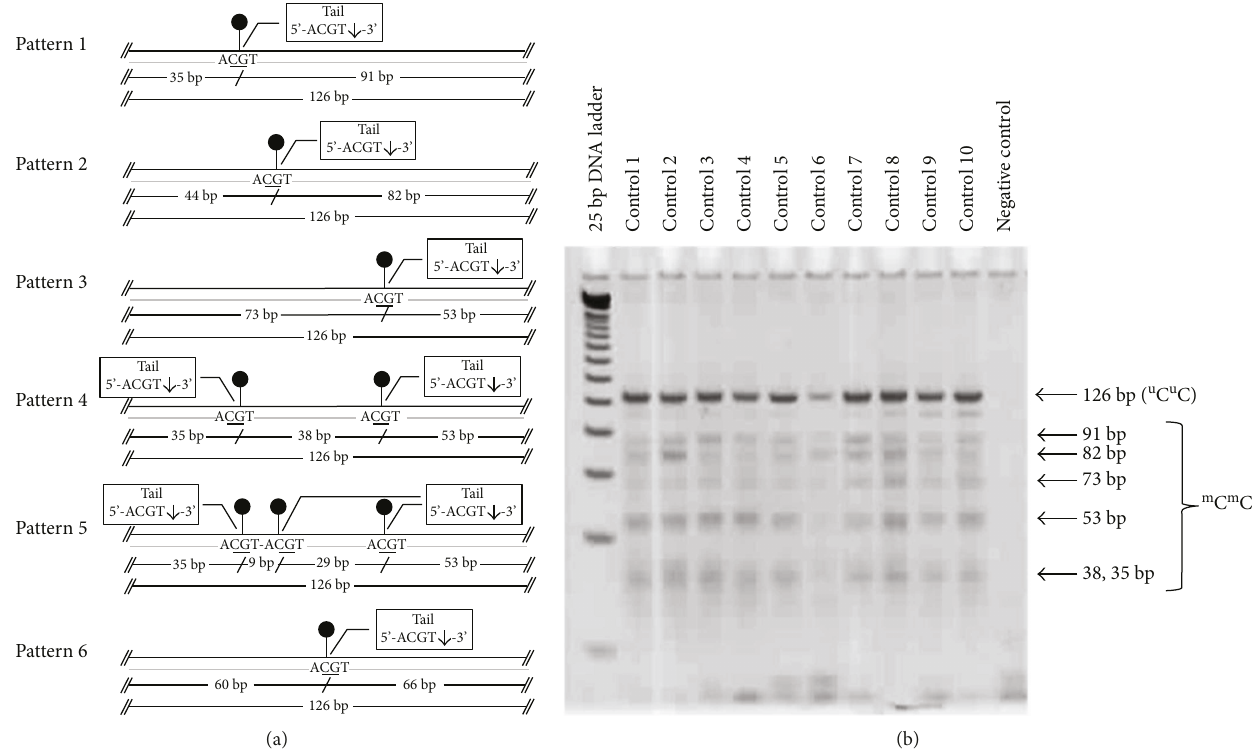
Figure 2: Combined-bisul fi te restriction analysis (COBRA) for HERV-E methylation patterns. The diagrams (a) demonstrate six patterns of hypermethylation ( m C m C). Polyacrylamide gel electrophoresis (b) shows the locations for the bands for each pattern of methylated CpGs. Quantitative DNA ladder was used to assess the size of the bands. The representative gels of cell line and normal control samples are shown. Water is used as a negative